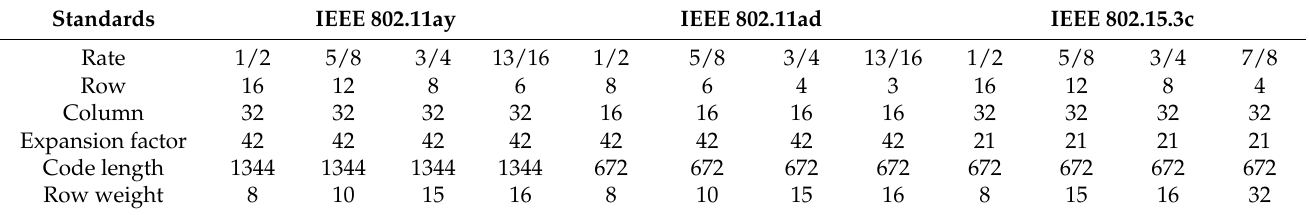
Figure 10. IEEE 802.11ay parity check matrix with R = ( a ) 1/2, ( b ) 5/8, ( c ) 3/4, and ( d ) 13/16. Table 2. Parameters of three standards for 60 GHz wireless local area